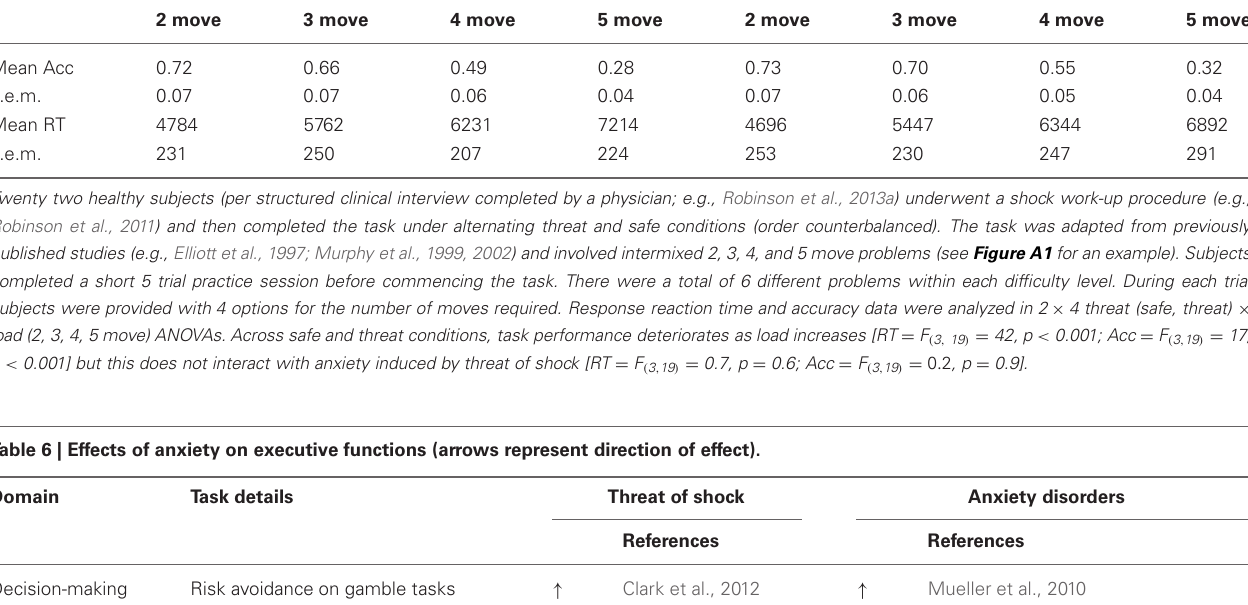
Table 5 | Impact of threat of shock on accuracy (Acc) and planning time (RT; ms) on the one touch tower of London task. Safe